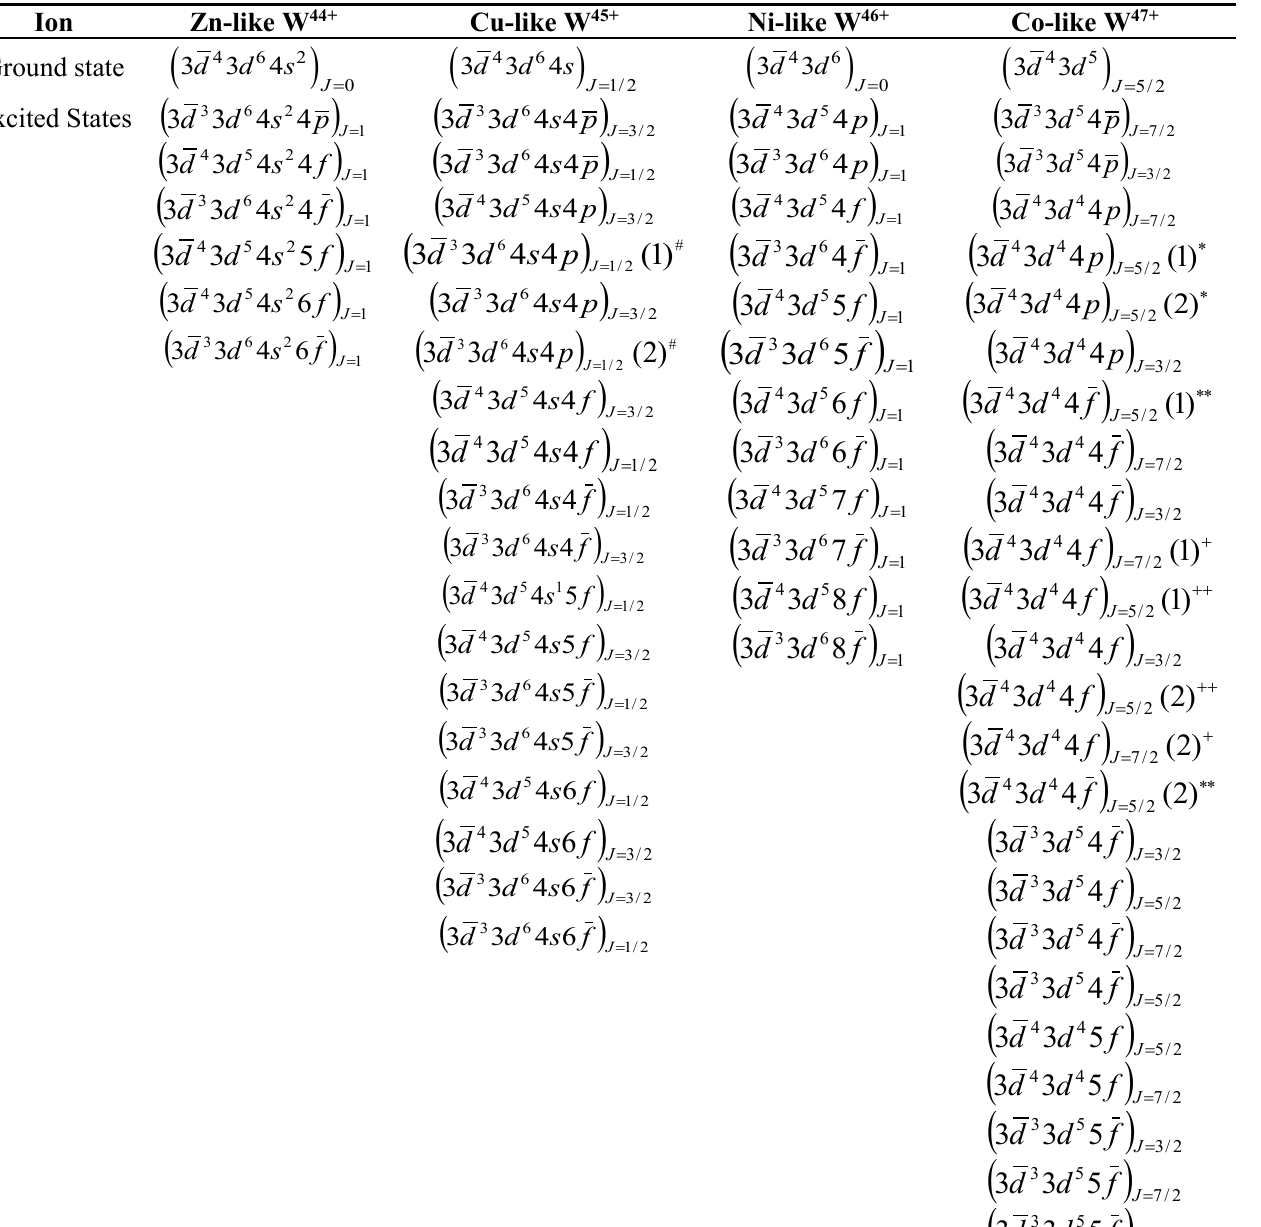
Table 3. M-shell excitations from the ground state of Zn-like W 44+ through Co-like W 47+ ions [25]. Ion Co-like W 47+ Ground state Excited